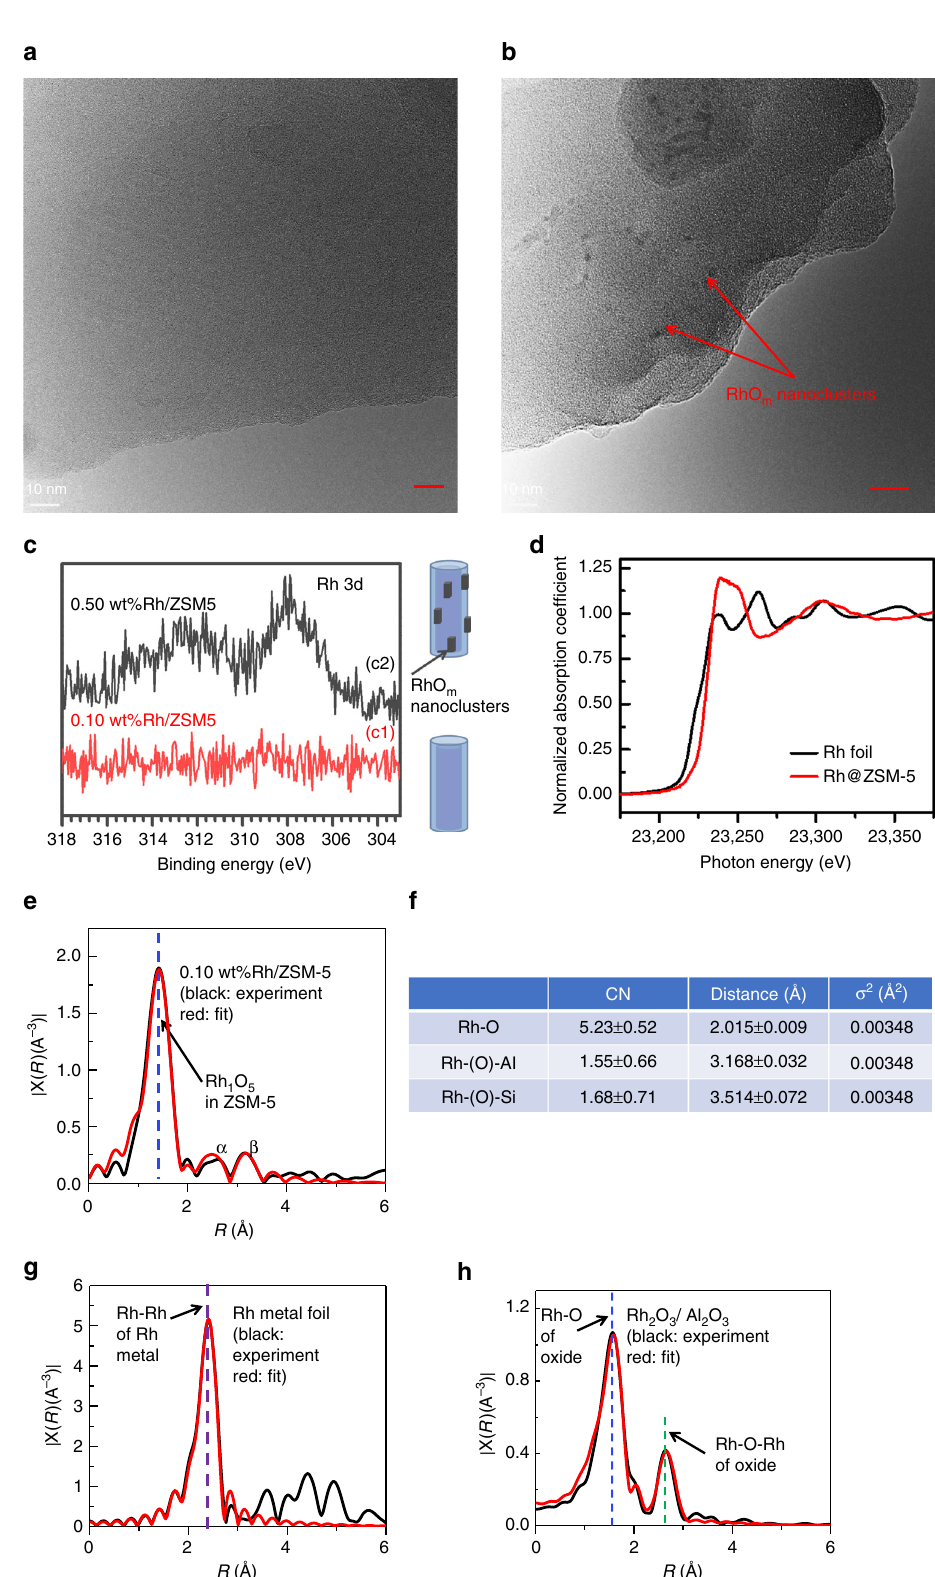
Fig. 1 Structural characterization of isolated rhodium atoms in ZSM-5. a TEM image of particles of 0.10wt%Rh/ZSM-5; scale bar: 10nm. b TEM image of particles of 0.50wt%Rh/ZSM-5; scale bar: 10nm. c Rh 3d XPS peak of 0.l0wt%Rh/ZSM-5 and 0.50wt%Rh/ZSM-5. d Energy space of Rh K-edge of 0.l0wt% Rh/ZSM-5 and Rh foil (reference sample) of X-ray absorption near edge spectra (XANES). e r-space of Rh K-edge of experimental (black) and calculated (red) data of the k 2 -weighted Rh K-edge EXAFS spectra of used 0.10wt%Rh/ZSM-5. f Coordination number and bond length on average of the used 0.10wt%Rh/ ZSM-5. g r-space of Rh K-edge of experimental (black) and calculated (red) data of the k 2 -weighted Rh K-edge EXAFS spectra of Rh metal foil. h r-space of Rh K-edge of experimental (black) and calculated (red) data of the k 2 -weighted Rh K-edge EXAFS spectra of Rh 2 O 3 nanoparticles supported on Al 2 O